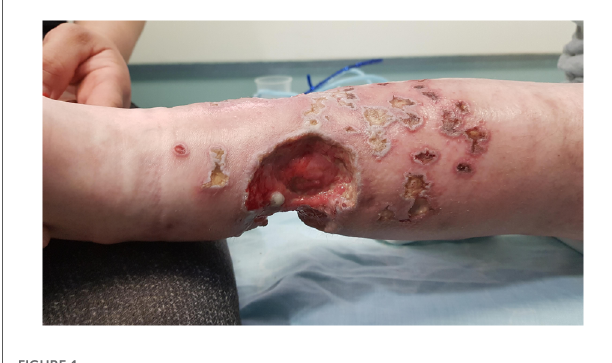
FIGURE 1 Multiple well demarcated, punched-out, ulcers with erythematous indurated borders, with fi brin on their base and an overlying hemorrhagic crust, on the lower leg of a 13.5-year-old boy with a combined immunode fi ciency syndrome, consistent with varicella-zoster virus infection overlying chronic ulcerative granulomas.